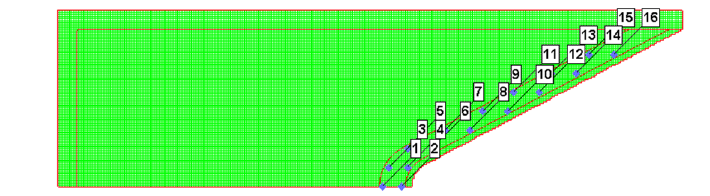
Figure 8. Penetration schematic of RM-CL shaped charge against steel target.